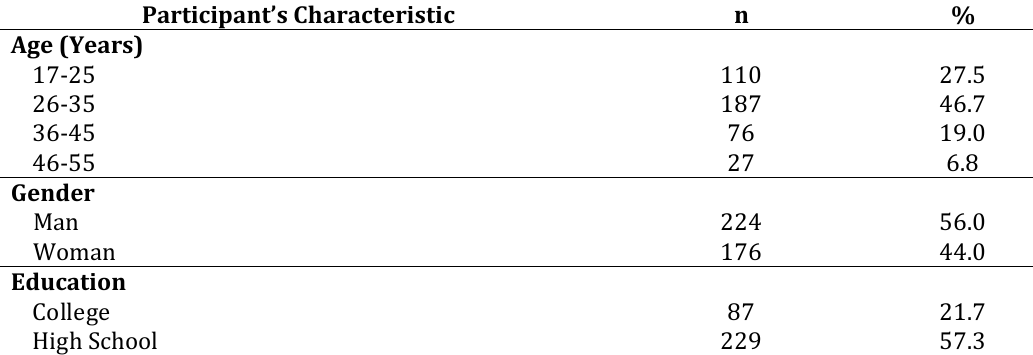
Responden t’s Characteristic Participant’s